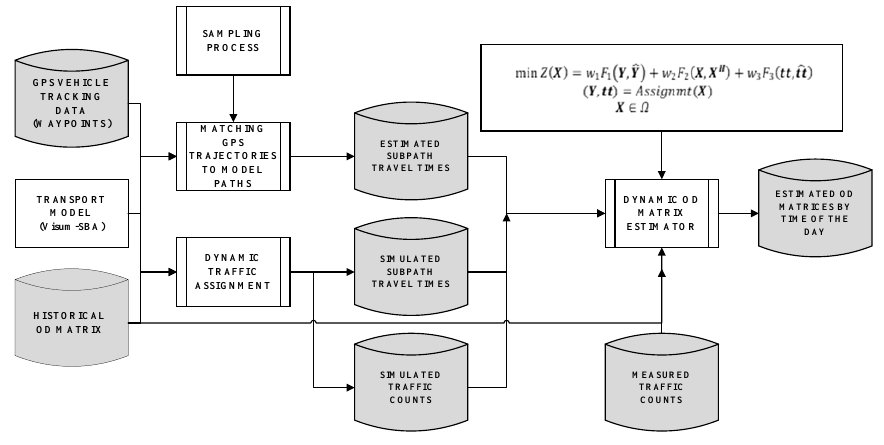
Figure 1. Methodological